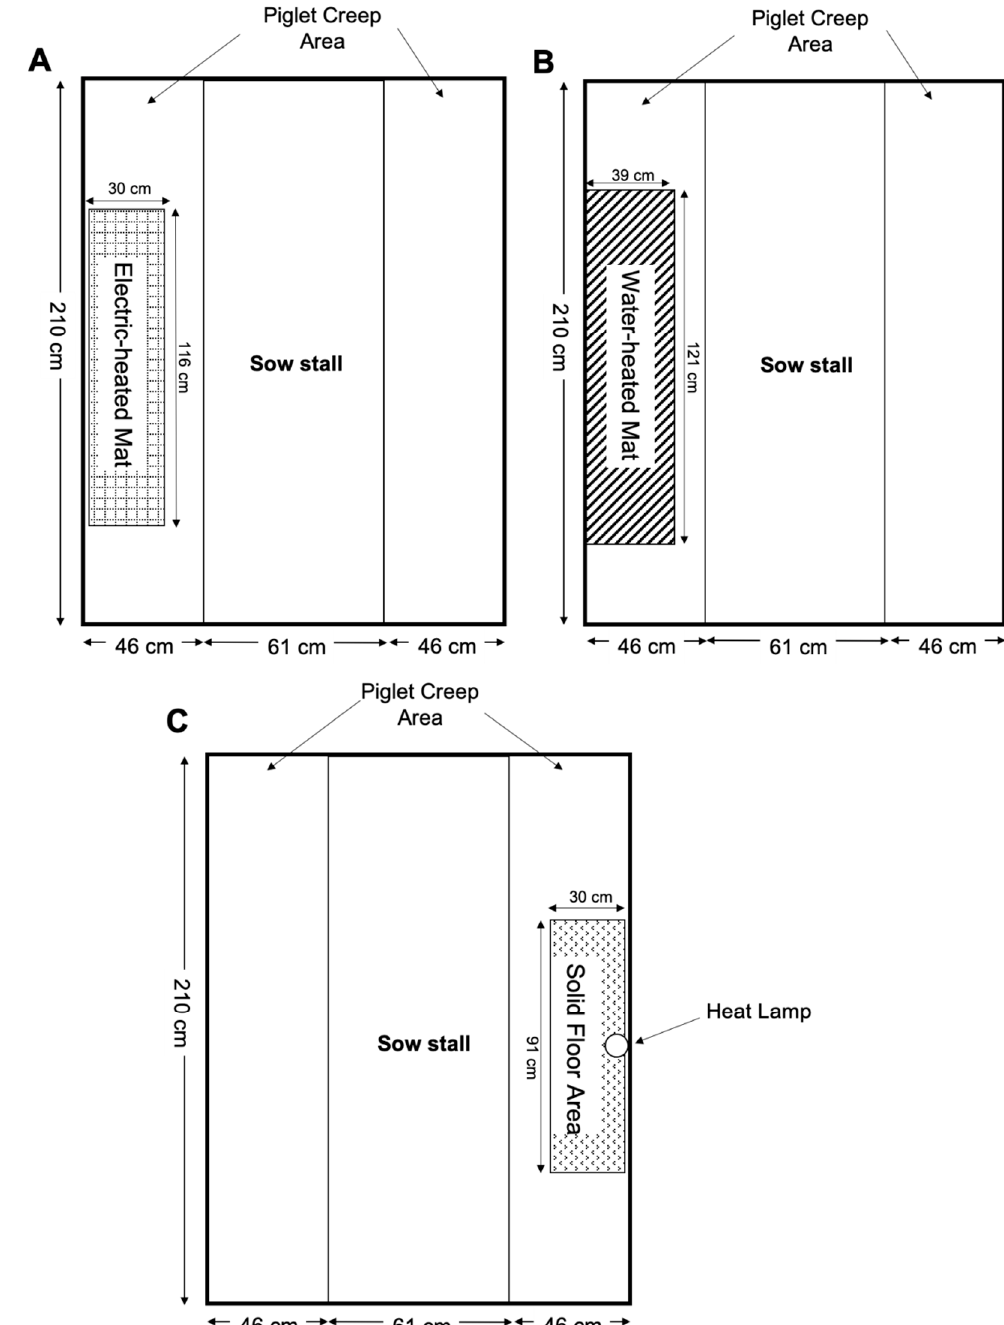
Figure 1. Layout of farrowing stalls: ( A ). Electric-heated mat; ( B ). water-heated mat; and ( C ). heat lamp. All sows and piglets were managed according to the WCROC’s standard operating procedures for farrowing and lactation. Sows farrowed naturally without artificial induction. Beginning the day after parturition, sows were fed an increasing quantity of feed according to appetite until day 4 postpartum. After day 4 postpartum, sows were allowed ad libitum access to feed until the day of weaning. Within 24 h after birth, piglets were processed (e.g., surgical castration, docking tail, and iron injection) and cross-fostered if the litter size was larger than 14. Only piglets heavier than the mean weight within litter were cross-fostered to ensure their compatibility in the recipient litter. Piglets were not offered creep feed and were weaned at 19.4 ± 1.20 (SD) days of age. After weaning, sows were moved to the gestation barn for heat detection and mating for the next breeding cycle.